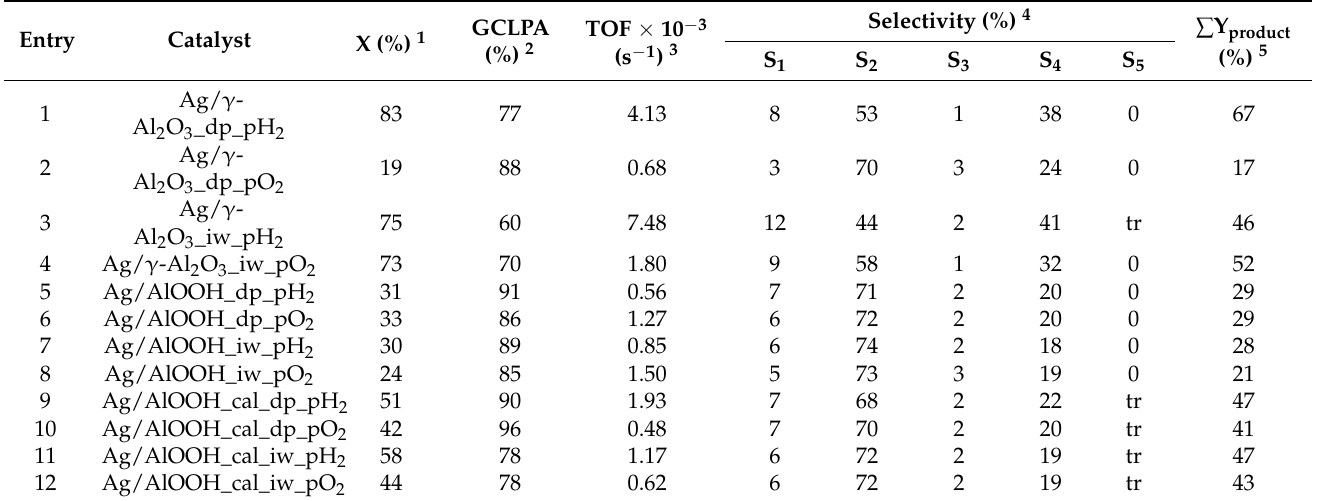
Table 3. Catalytic results for betulin oxidation over Ag catalysts.